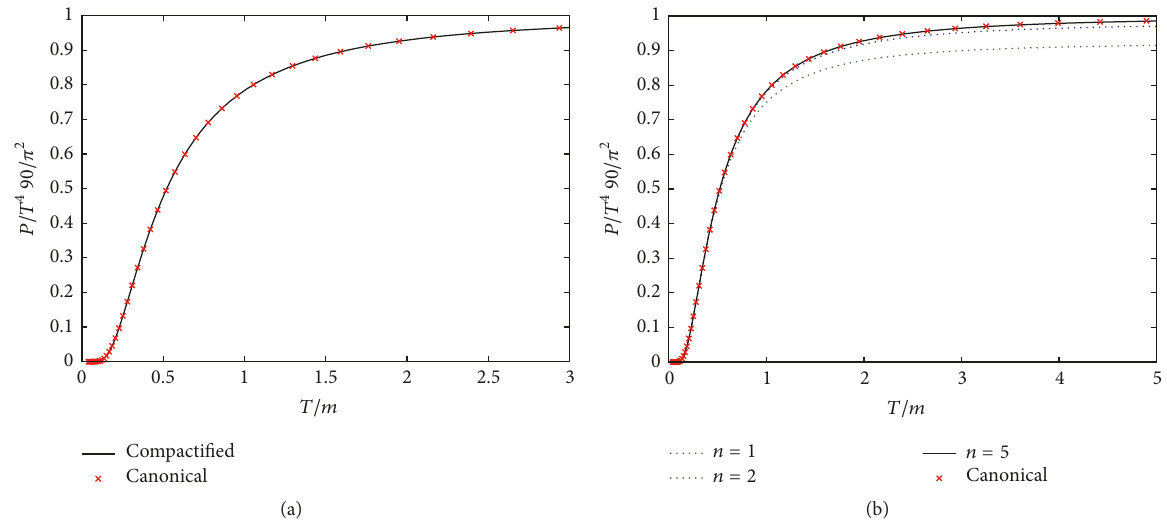
Figure 14: The pressure of a free massive Bose gas (a) calculated from equation (59) (full curve) and from the grand canonical ensemble (54) (crosses). (b) The pressure when the summation index in equation (59) is restricted to |𝑛| = 1, 2 and 5 .